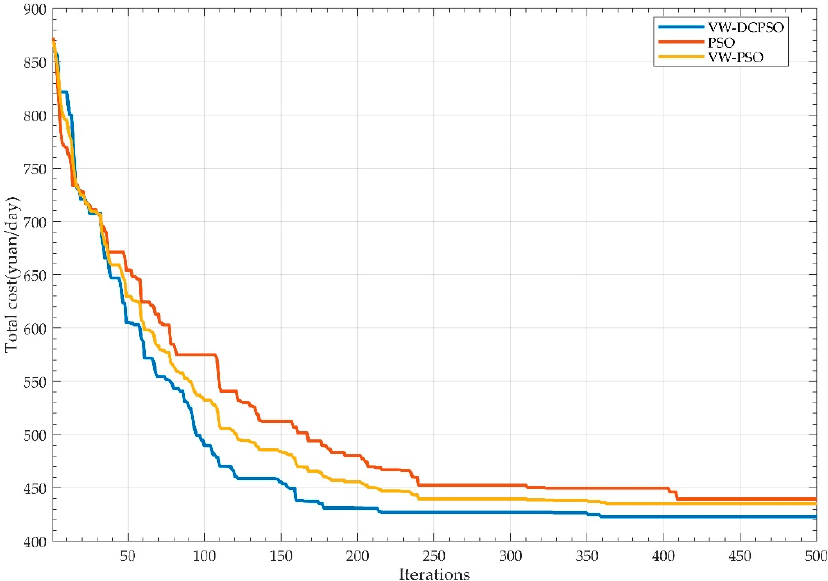
Figure 6. Iterative process comparison of the three algorithms